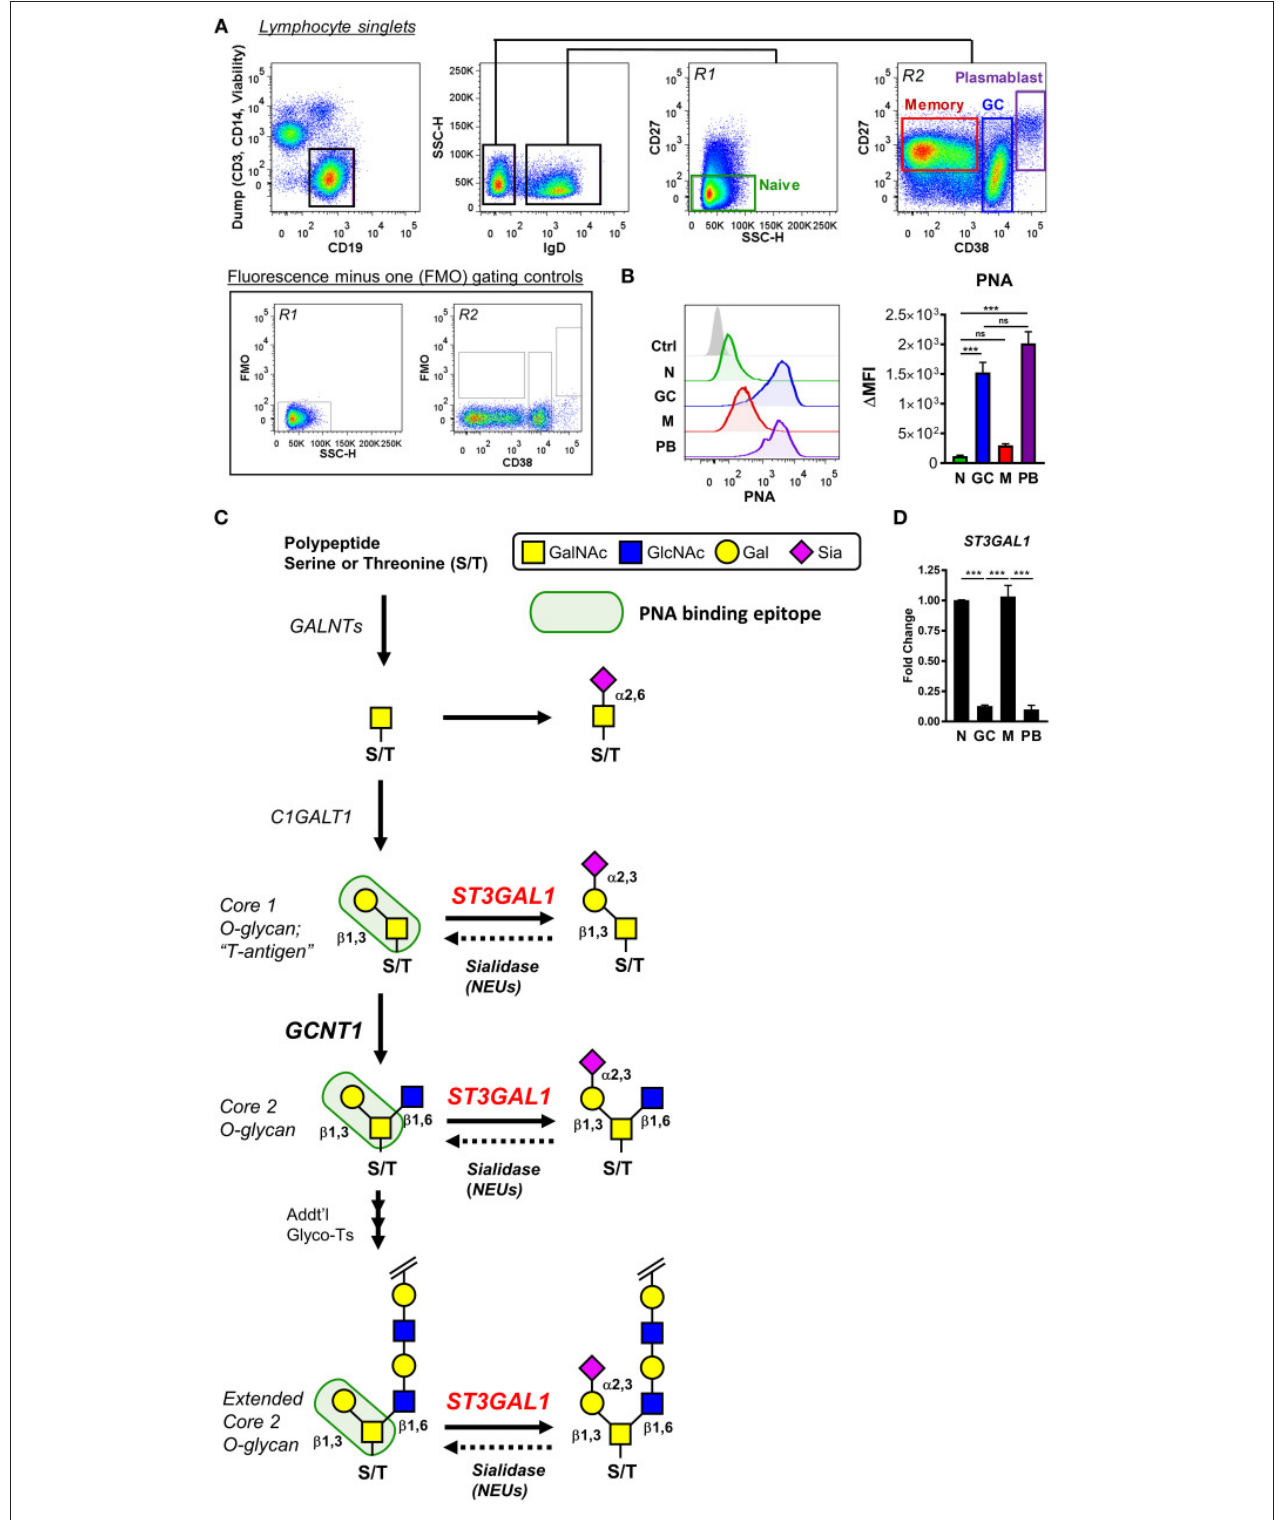
FIGURE 1 | Expression of PNA-reactive glycans by germinal center B cells is correlated with downregulation of the α 2,3-sialyltransferase ST3Gal1. (A) Gating strategy for analyzing tonsillar naïve (N), germinal center (GC), memory (M), and plasmablast (PB) B cells by flow cytometry. Representative fluorescence minus one (FMO)